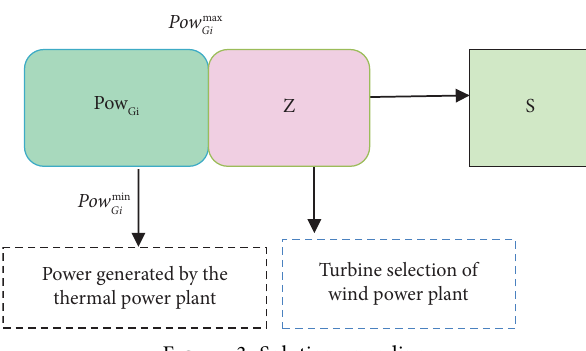
Figure 3: Solution